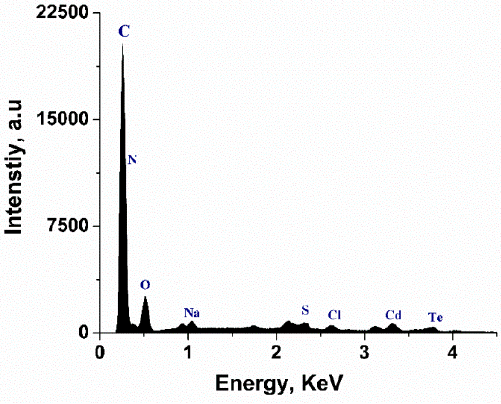
Figure 2. FESEM images of ( a ) cellulose-CdTeQD composite film and ( b ) cellulose film.